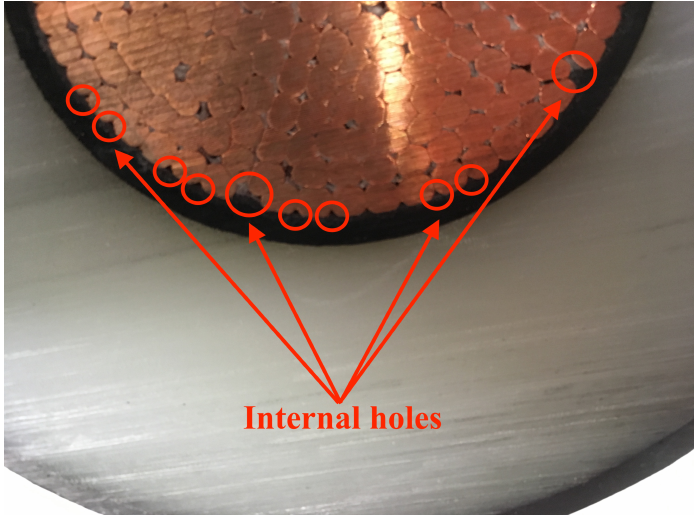
Figure 2. An XLPE-insulated power cable sample showing the internal holes along the interface of the ISC and the cable conductor and within the